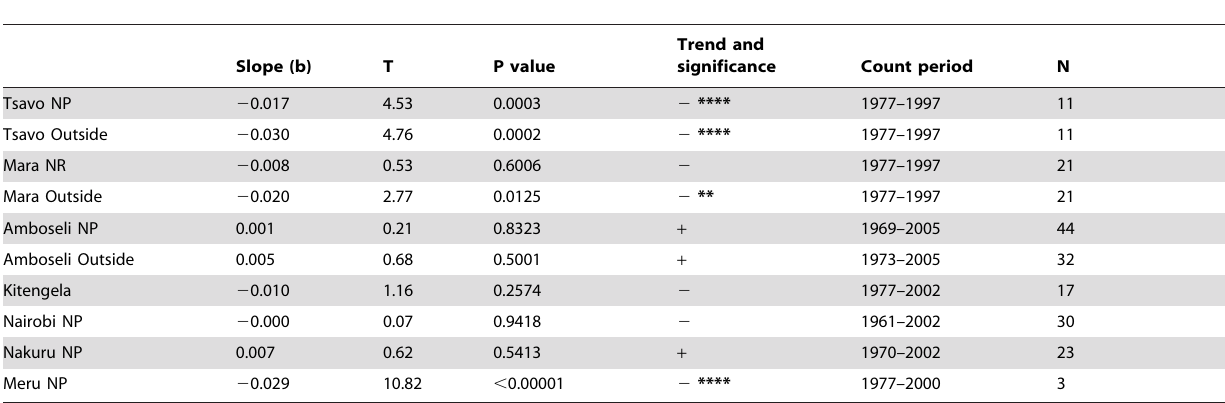
Table 1. Trends in large mammal numbers for key parks, reserves and adjoining non-protected areas within the